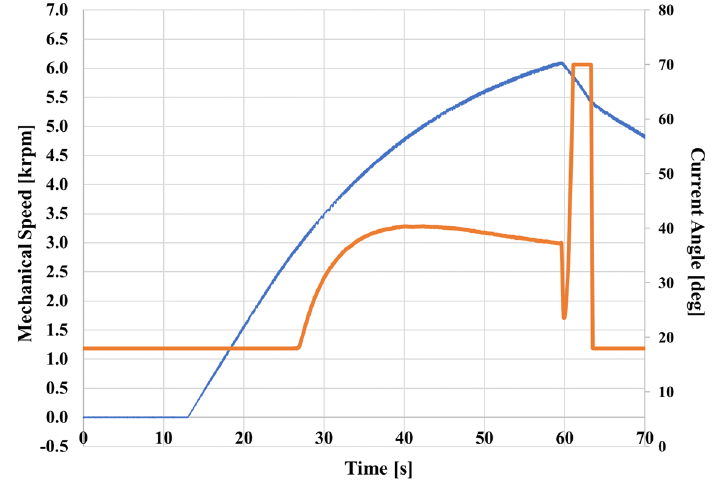
Figure 11. Experimental results of outer voltage control [17]. Current angle (orange solid line) and angular mechanical speed (blue solid line).